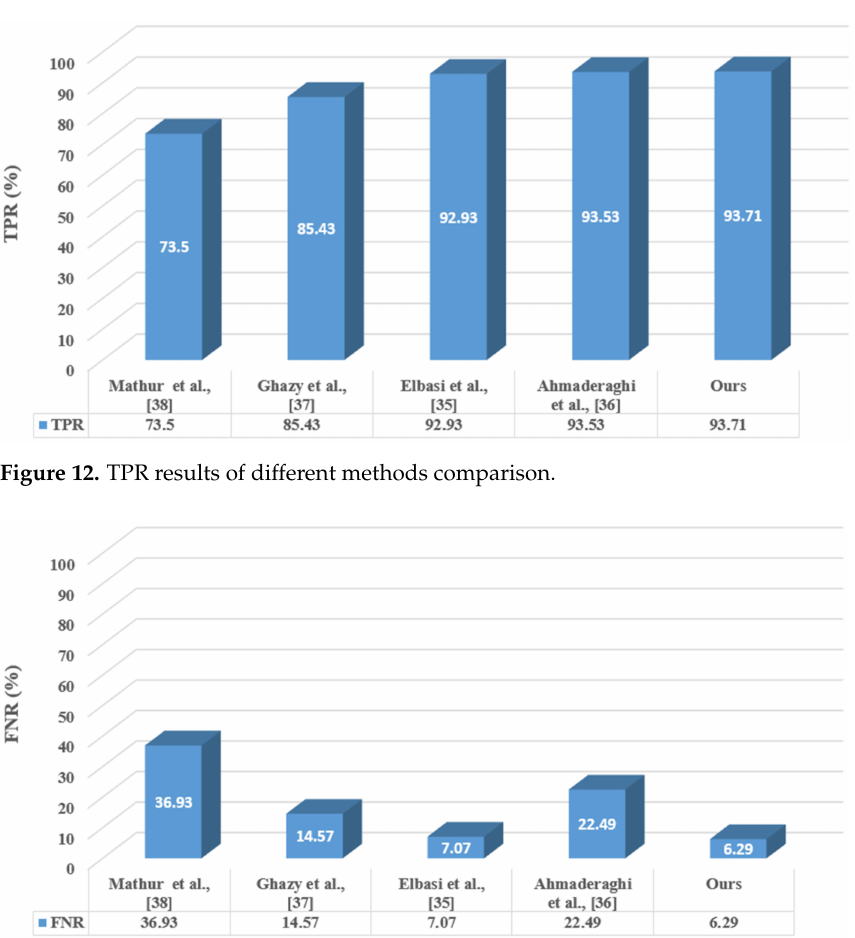
Figure 13. FNR results of different methods